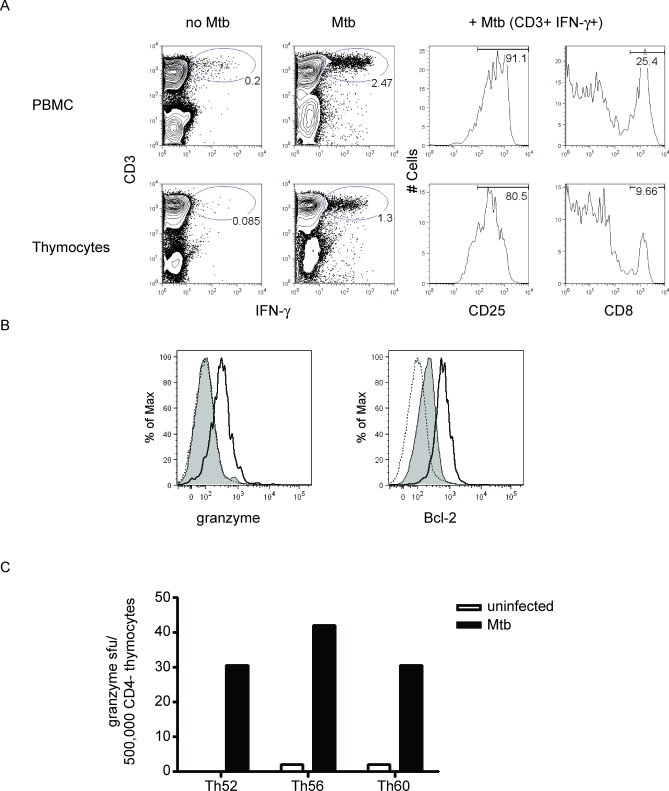
Mtb-Reactive Thymocytes Display Molecules Associated with an Activated Effector Phenotype(A) Unfractionated thymocytes (500,000 cells/well) and positive control PBMC (500,000 cells/well) were incubated with allogeneic DC (50,000 cells/well) infected with Mtb or left uninfected and IFN-γ assessed using the ICS assay. Non-specific binding by the mouse IgG1 PE isotype was not observed. The numbers in the graphs represent the percentage of IFN-γ-positive cells of unfractionated cells. Histograms represent expression of CD25, and CD8 on gated CD3+IFN-γ+ cells after stimulation with Mtb.(B) Histograms depicting granzyme and Bcl-2 expression from CD3+IFN-γ+-gated cells after stimulation with Mtb. Dotted line: isotype control antibody; Shaded histogram: granzyme or Bcl-2 expression on total CD3+ thymocytes; Bold line: granzyme or Bcl-2 expression on IFN-γ+ CD3+ cells (Mtb-reactive). Data are representative of a minimum of 4 thymocyte donors.(C) CD4-depleted thymocytes (500,000 cells/well) from 3 individuals were tested for their ability to secrete granzyme in an ELISPOT assay in response to DC (50,000 cells/well) that were uninfected or infected overnight with Mtb (moi 30).